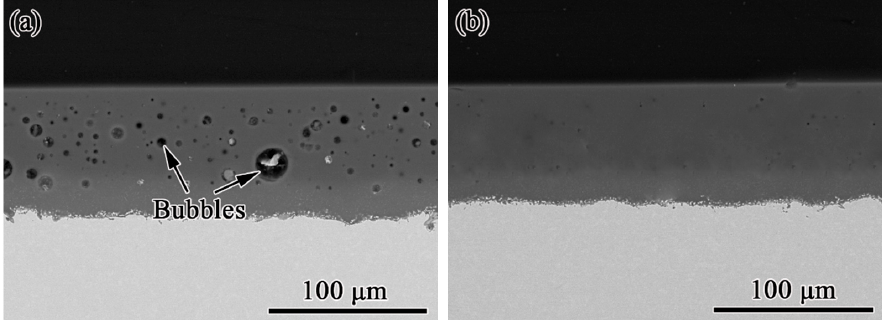
Figure 1. Initial cross-sectional morphologies of the HS firing in air ( a ) and in a vacuum ( b ) at 880 °C.